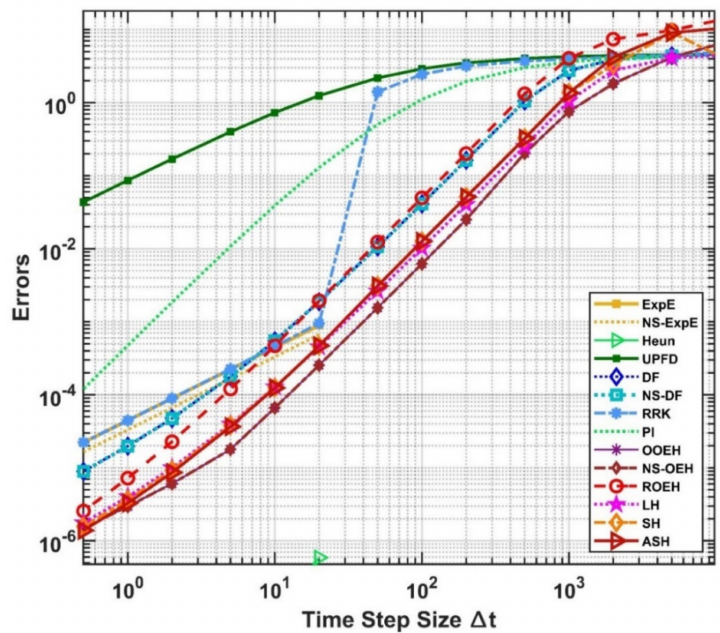
Figure 7. The maximum errors as a function of the time step size ∆ t for the 14 examined methods in the case of a surface